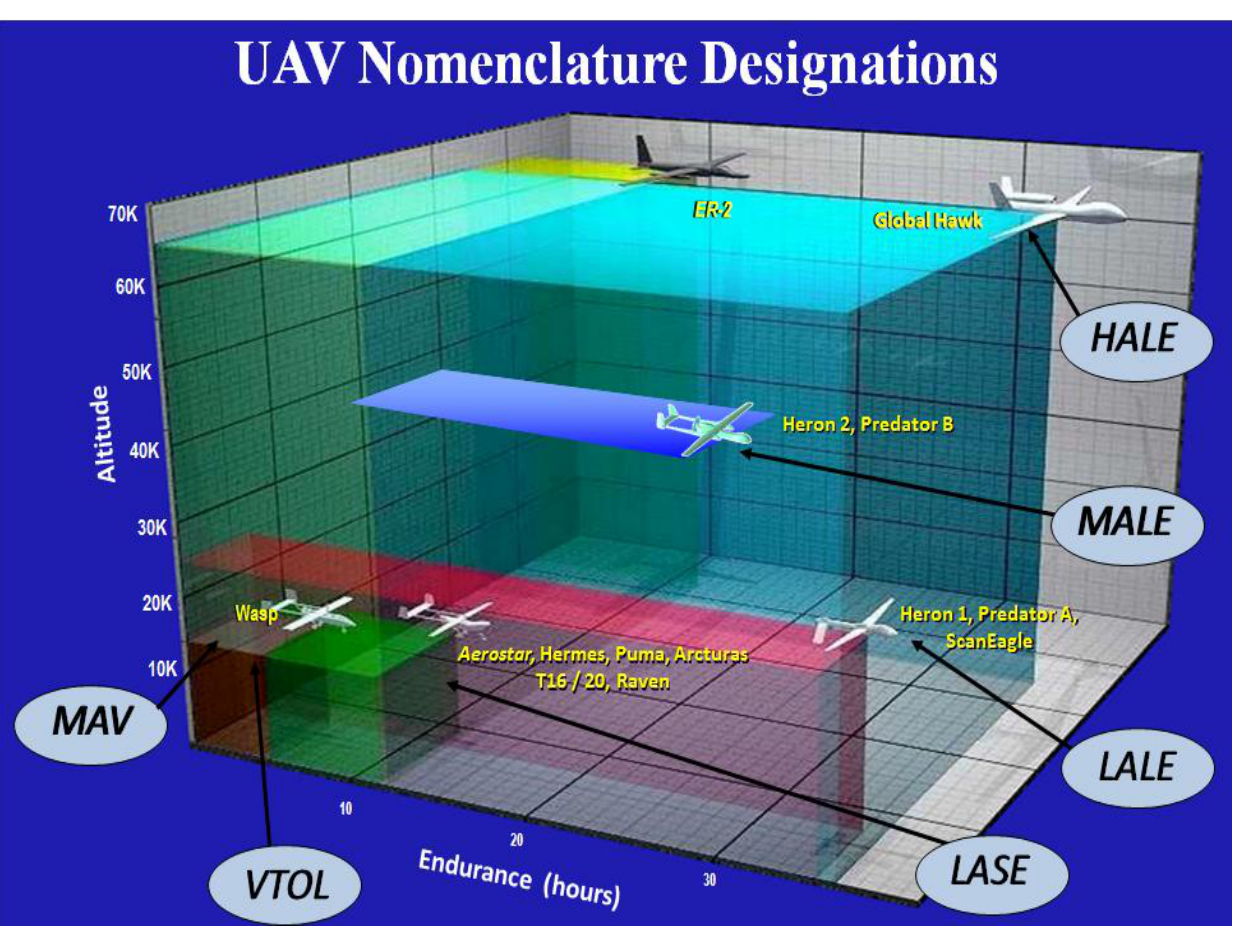
Figure 1. Image courtesy of US Department of Homeland Security